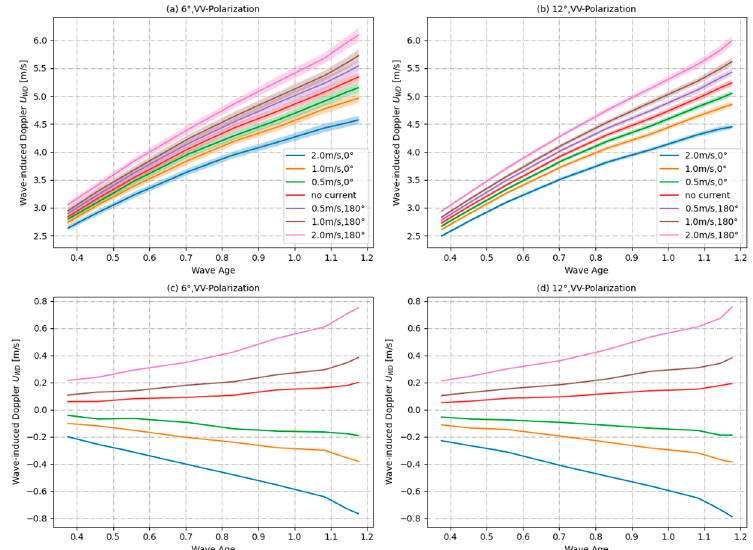
Figure 23. ( a , b ) represent the variation in U WD with wave age for radar incidence angles of 6° and 12°, wind speed of 10 m/s, and sea surface currents of 0.5, 1, and 2 m/s when they are in downwind and upwind directions, respectively. The colored solid lines indicate the U WD , and the corresponding colored shading is the standard deviation. ( c , d ) correspond to ( a , b ) and indicate the difference in U WD between the presence and absence of current.